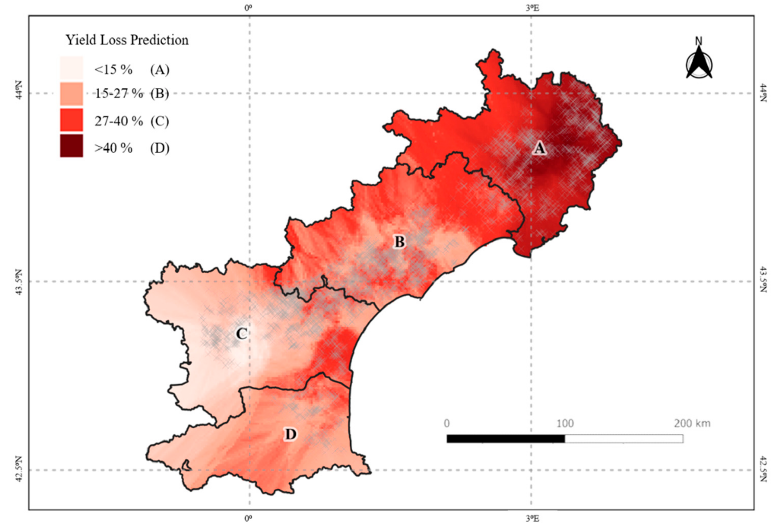
Figure 10. Kriged map of yield loss predictions at a regional scale derived from the N-PLS model.